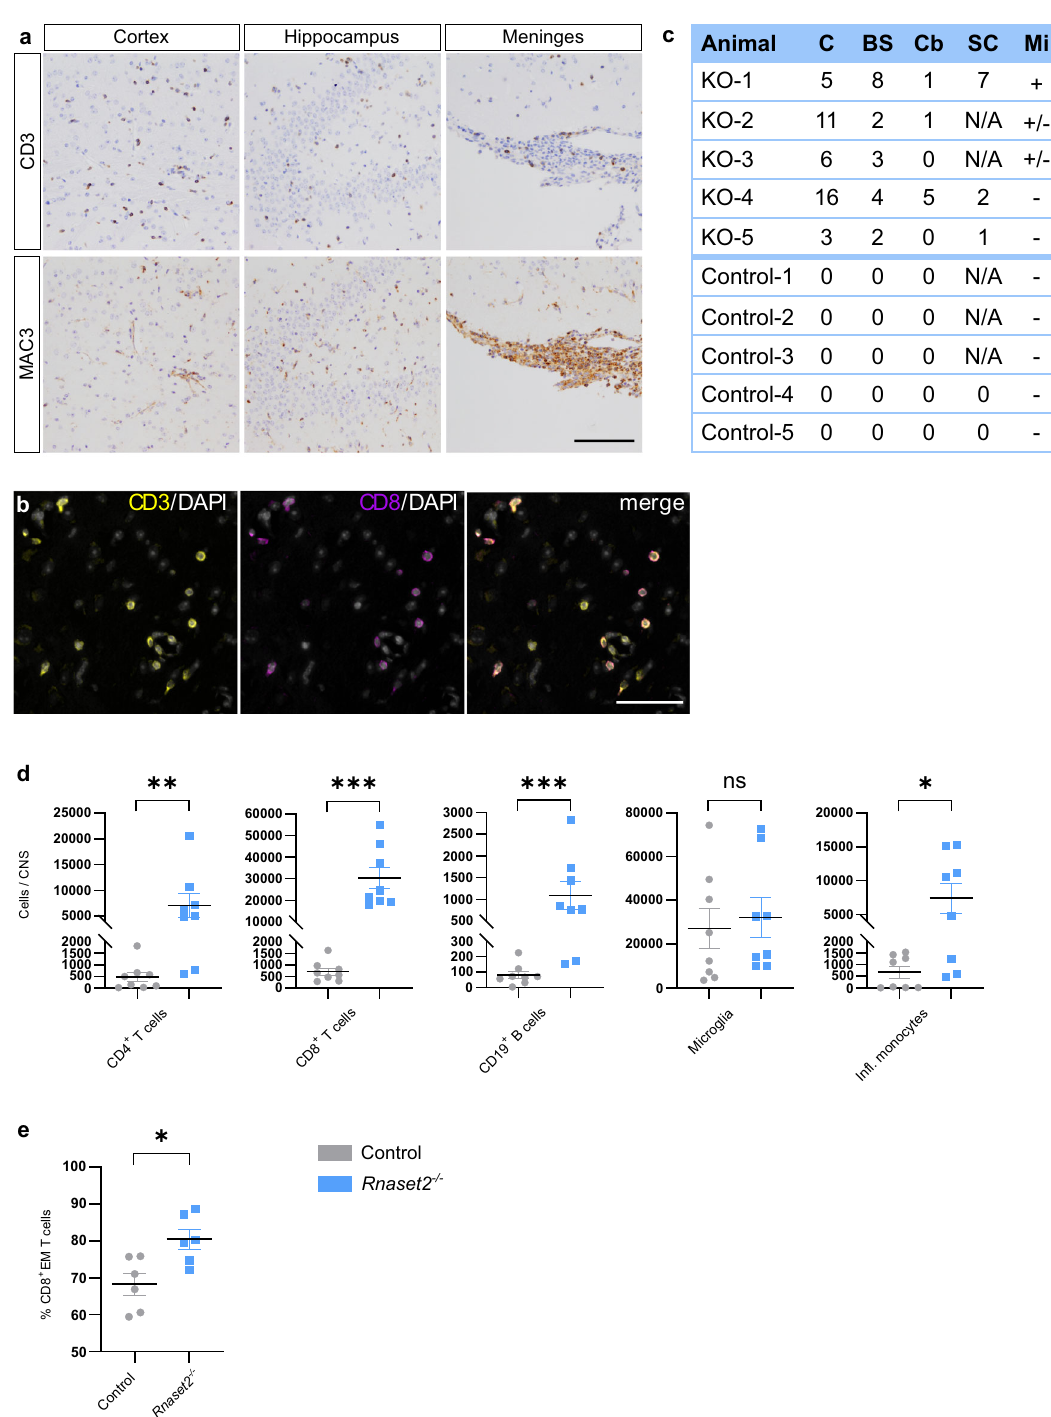
difference between Rnaset2 − / − and control mice (Supplementary inhibitory neurons (Supplementary Fig. 10f). Differential expres-